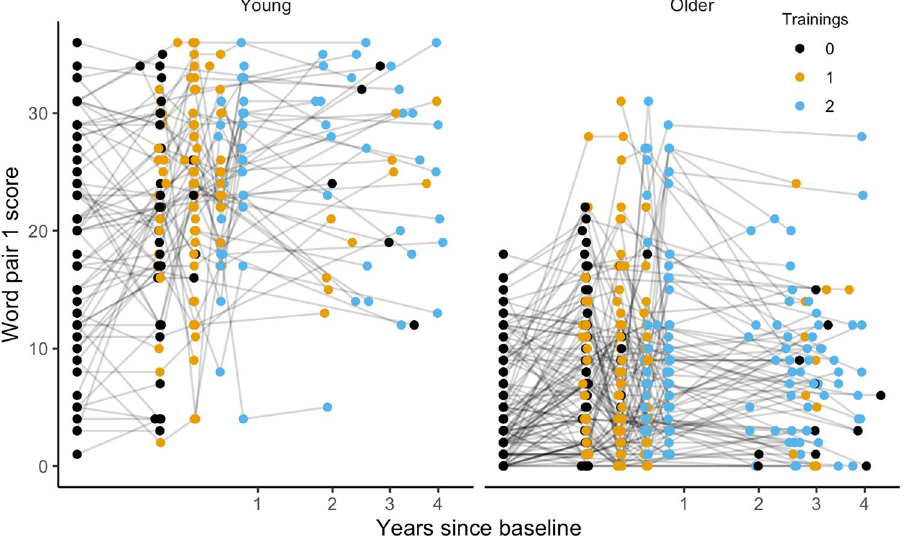
Figure 5. Scores on the word-pair task. The labels show the number of trainings (none, 1, or 2) each participant has completed at the given time point. Repeated measurements of a single individual are connected with gray lines. Lines between training time-points (within the first year) are stretched horizontally, while lines years after cessation (long-term passive period) are compressed for illustrational